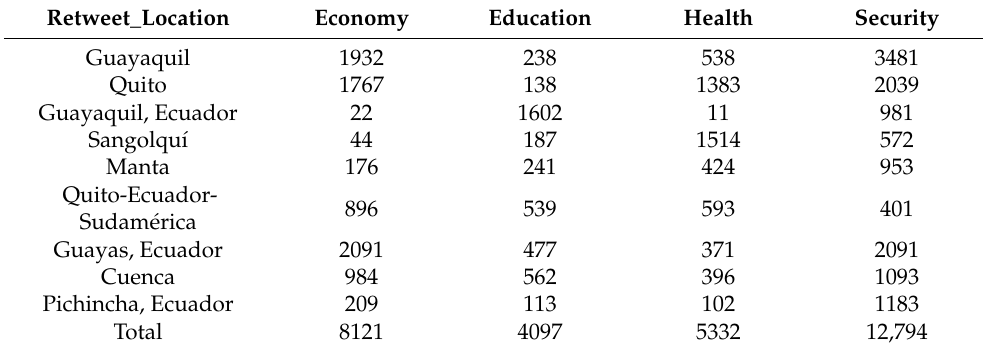
Table 2. Results obtained from the extraction of tweets in each search category.